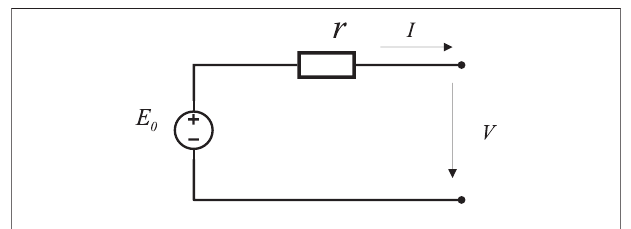
FIGURE 1 | Simpli fi ed equivalent circuit diagram of the energy storage battery.